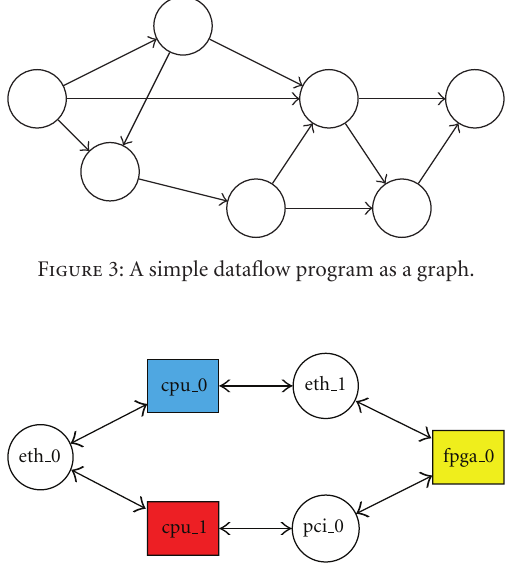
Figure 4: An example of a ring architecture composed of 3 op- erators and 3